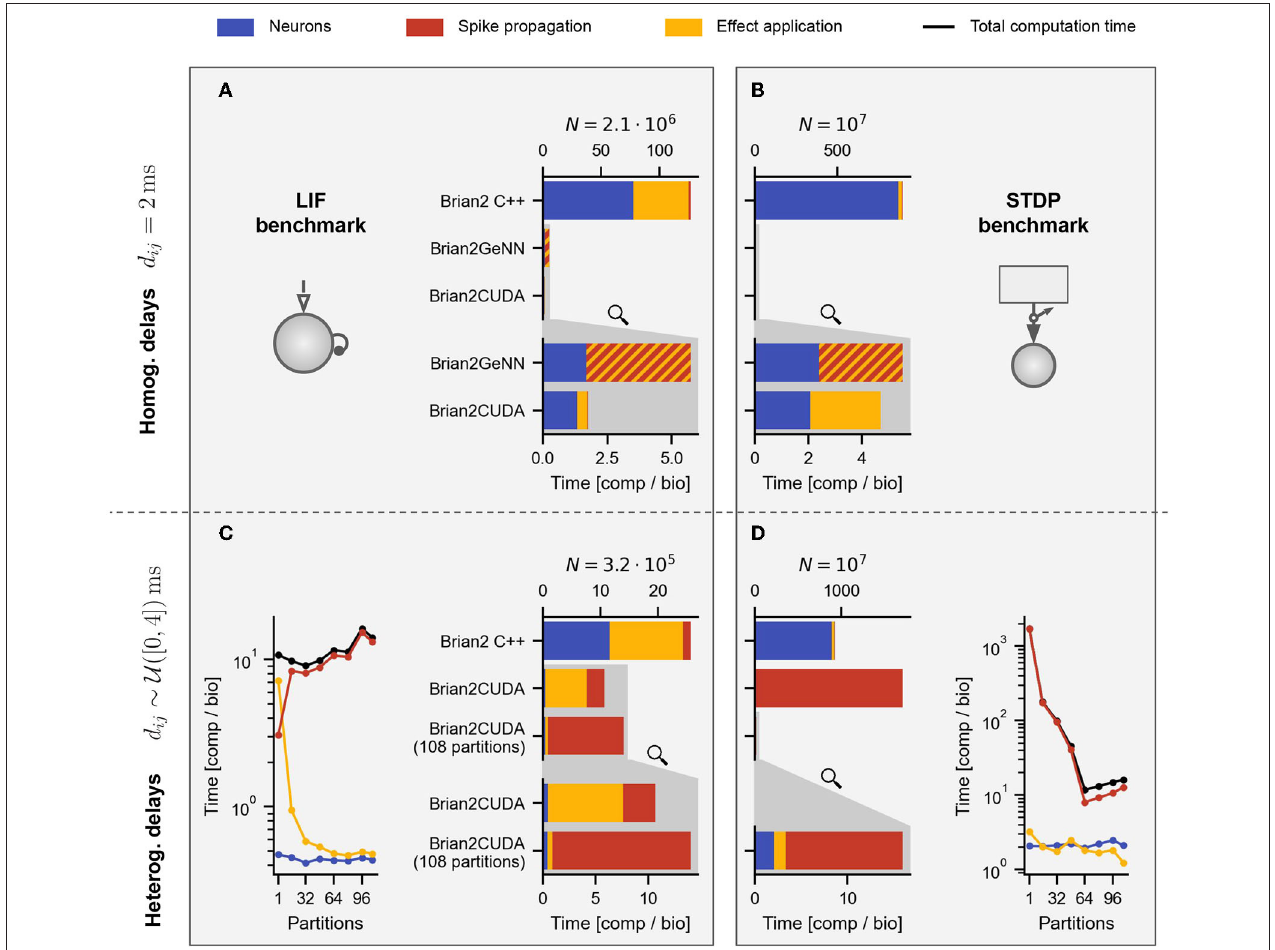
FIGURE 7 | Profiling results for benchmarks with homogeneous and heterogeneous delays. (A,B) Profiling results for LIF (A) and STDP (B) benchmarks with homogeneous delays for the respectively largest population of Figures 5C,D . (C,D) Profiling results for LIF (C) and STDP (D) benchmarks with heterogeneous delays for the largest population size of Figures 6A,B . For the STDP benchmarks in (B,D) , the Poisson spike generators are included in the neuronal computation times (blue). The gray shaded areas in the lower part of (A–D) contain zooms of the respective GPU simulations in the middle (indicated by the magnifying glass symbol). ( C , left) and ( D , right) show profiling results for different numbers of partitions of the connectivity matrix in Brian2CUDA. Black lines are the total computation times for the main time loop (cf. Figure 6C ). In all panels, Brian C++ was simulated with 16 threads, Brian2CUDA was simulated without connectivity matrix partitioning if not stated otherwise and Brian2GeNN was simulated in post mode for (A) and in pre mode for (B) . For Brian2GeNN, only the combined time of spike propagation and effect application (striped bars) was recorded since both are combined into a single CUDA kernel. All simulations were performed as described in Figure 5 , but with enabled profiling measurements leading to slightly higher total computation